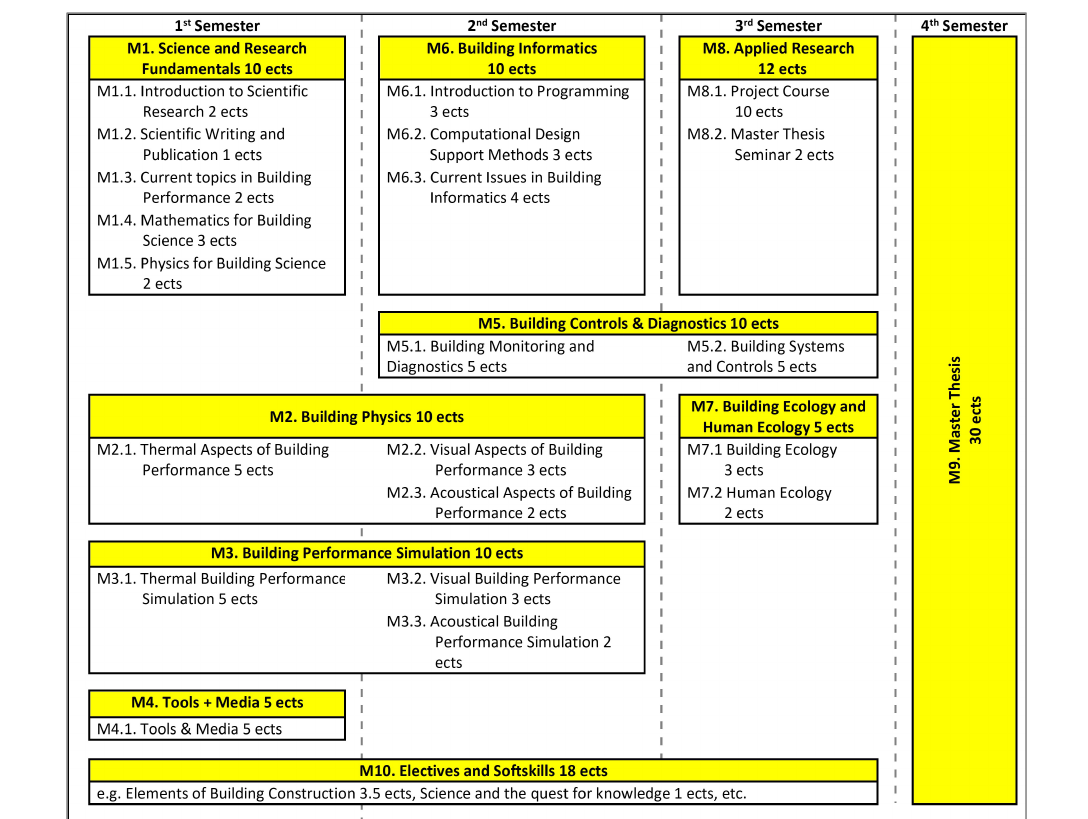
Figure 1. Structure of the BST